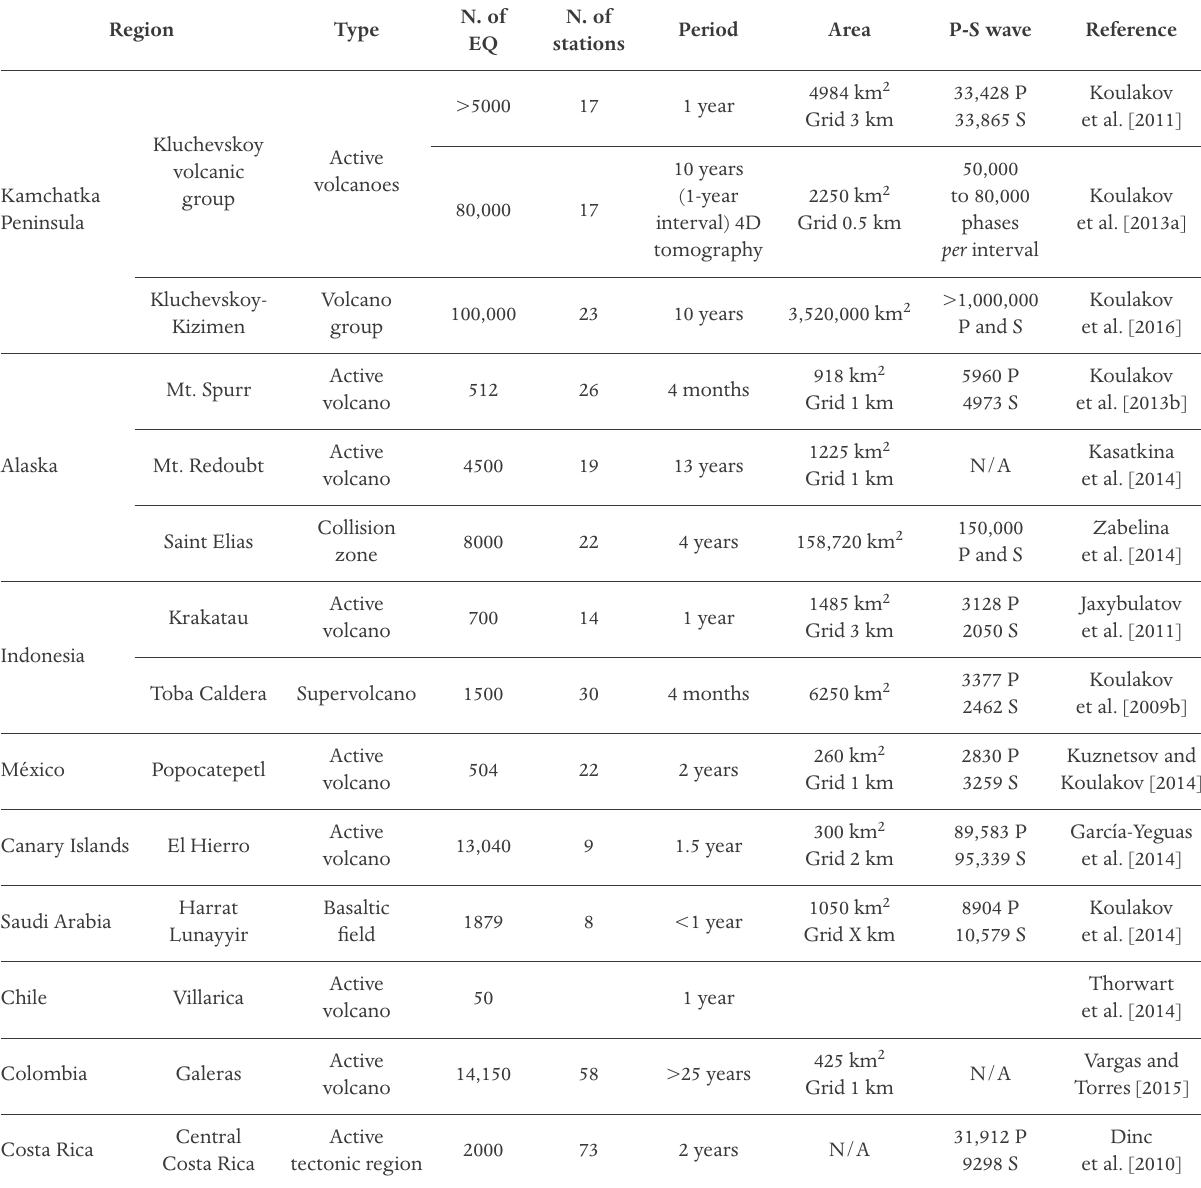
Table 1. Recent most relevant tomographic studies performed using LOTOS